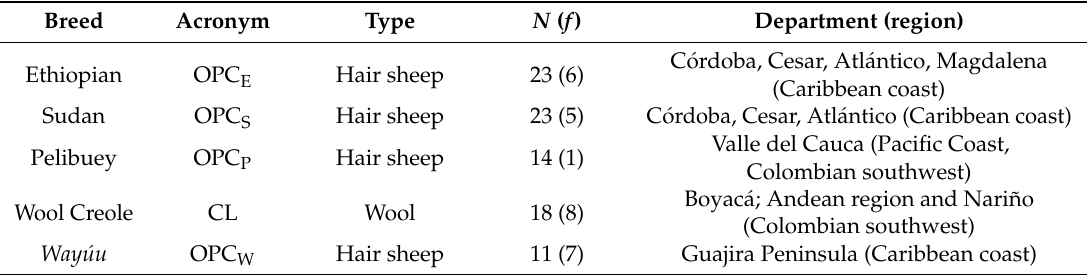
N— number of sampled animals; f —number of herds considered.